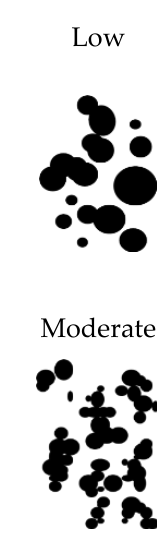
Figure 1. Dimensional and structural differences between Thermax ® N990 thermal black (TB) and Tokai ® N762 furnace carbon black (CB).